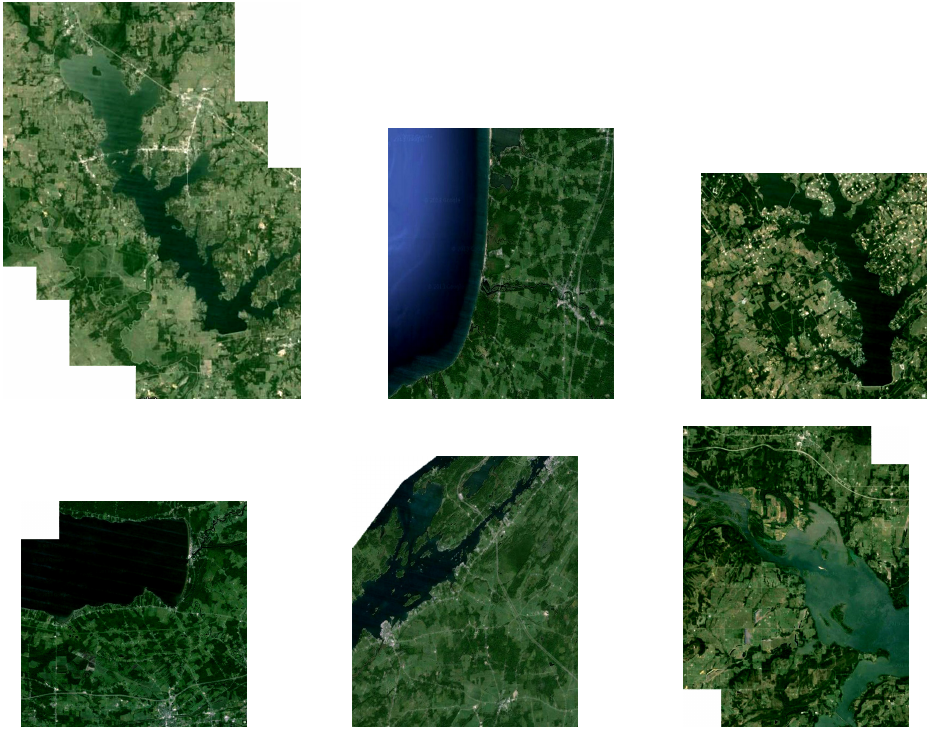
Figure 8. The remotely sensed images taken from Google Earth corresponding to the scenes shown in Figure 6 (for visualization, the histogram of the image has been